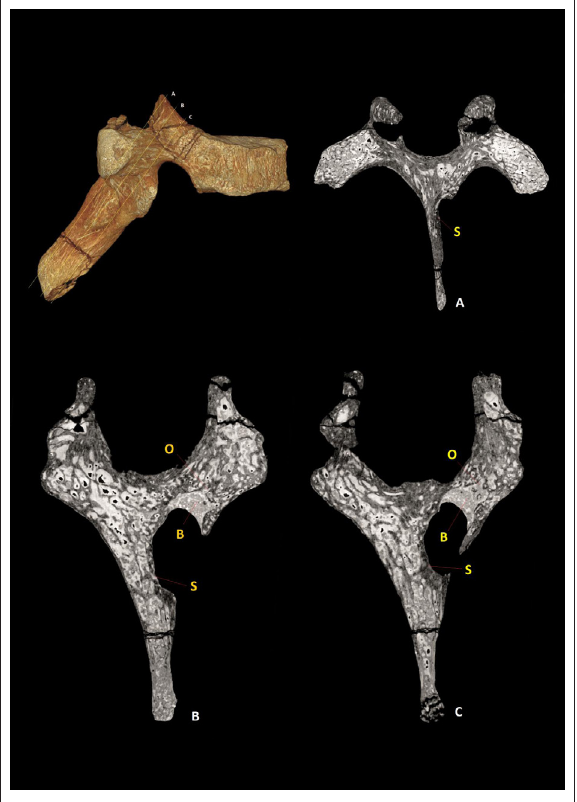
Figure 5: Transverse slices through vertebra U.W. 88-37 derived from phase-contrast X-ray synchrotron microtomography. Relative position and anatomical orientation of orthoslices (a), (b) and (c) shown on the volume-rendered model. The posterior portion of the lesion is sclerotic with circumscribed margins of well-integrated cortical bone, abutted and intersected by trabecular striae, with remodelling and reorganisation of the cortex. The anterior portion of the lesion displays a geographic pattern of bone destruction, showing a sharp non- sclerotic margin and evidence of active osteolytic processes, with sharply defined transection of individual trabeculae and active osteolytic penetration into the anterior portion of the lamina. Image produced by